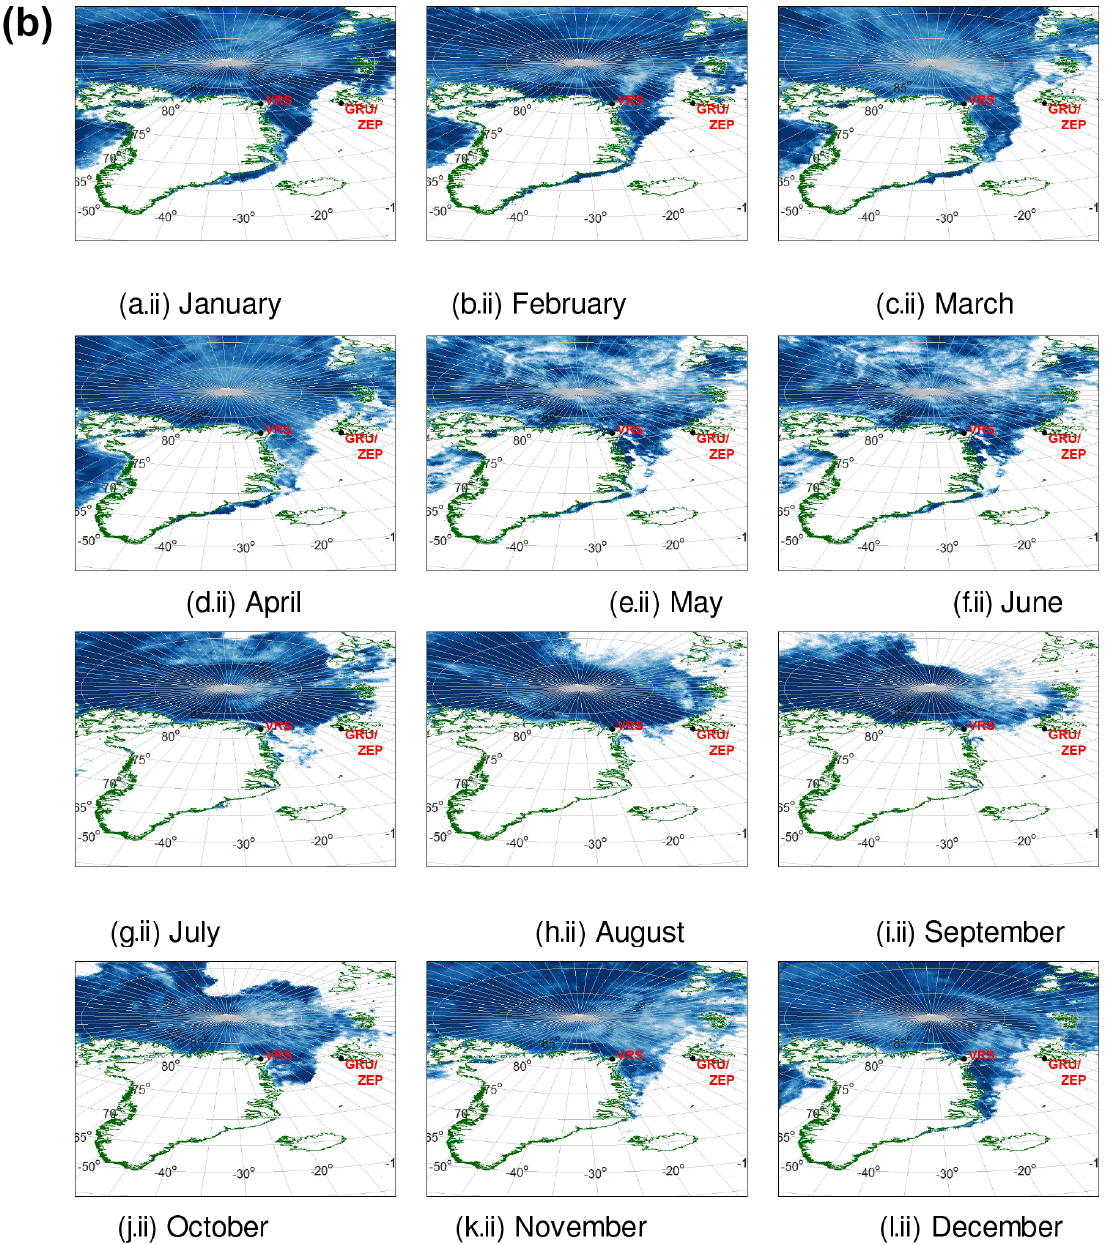
Figure 1. (a) Sea ice (light blue), open water (dark blue), snow on land (grey) and land (light green) maps for the period March–October (a– h) . Land borders are marked in dark green. (b) Sea ice maps (sea ice in dark blue) for the period March–October (a–h) . Land borders are marked in dark green. Snow, land and open water are in